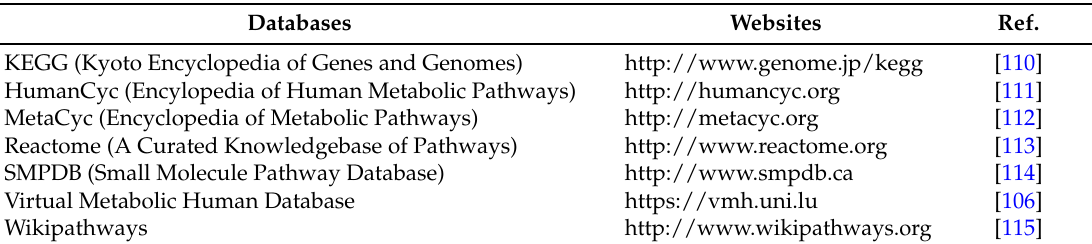
Table 2. Biological